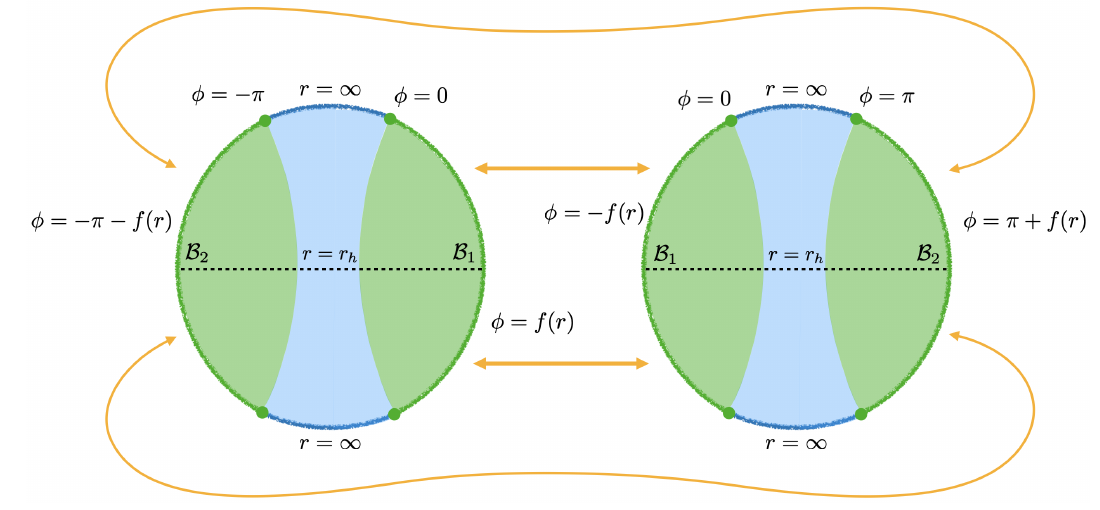
Figure 8 . Sketch of a t = 0 slice of the geometry in the deconfined phase. The two branes, denoted with B and B in green, cross the wormhole at antipodal points on the boundary circle. The orange 1 2 arrows indicate two geometries are glued together along the brane